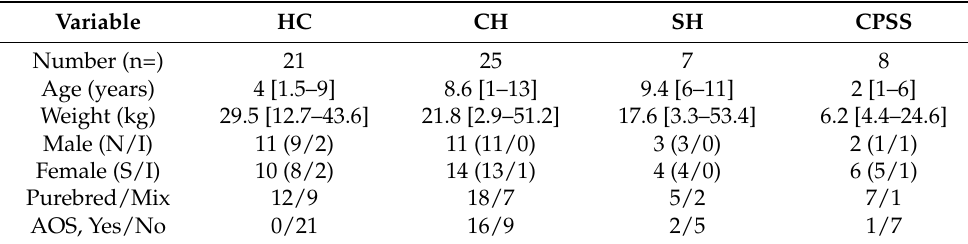
Table 1. Signalment, bodyweight, breed distribution, and antioxidant supplementation status of healthy control dogs and dogs with CH, SH, or CPSS. Age and bodyweights are reported as medians